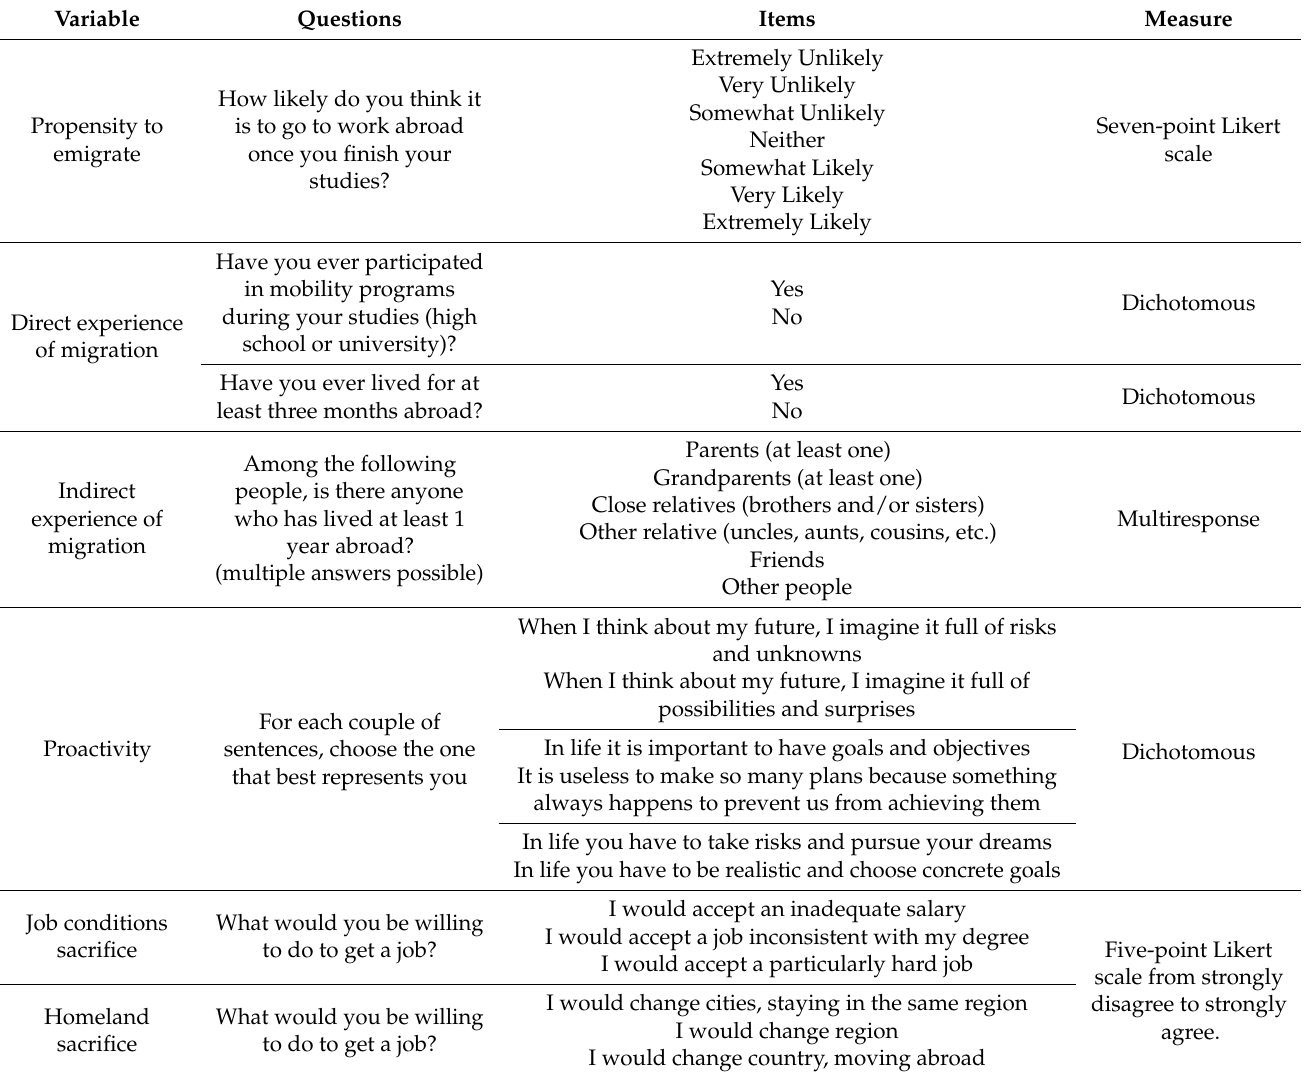
Table 2. Operational definition of the variables included in the multiple regression